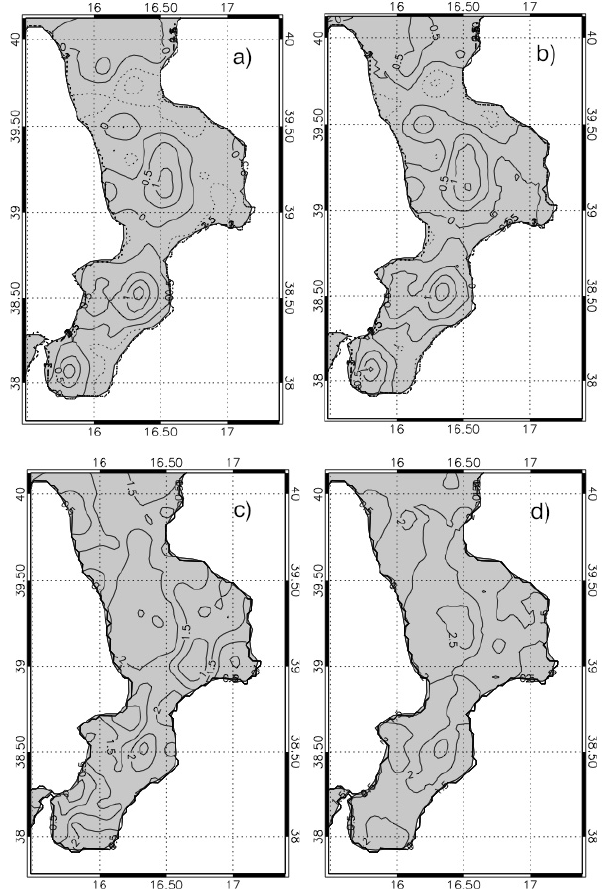
Fig. 8. (a) Mean temperature bias for the first-day forecast; (b) As in Fig. 8a, but for the fourth-day forecast; (c) Mean temperature RMSE for the first-day forecast; (d) As in Fig. 8c, but for the fourth- day forecast. Contours drawn at interval of 0.5 ◦ .